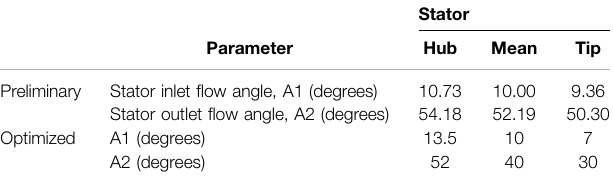
TABLE 5 | Stator main geometric and fl ow angle